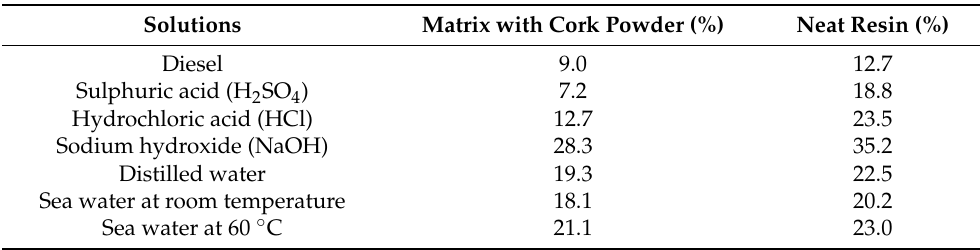
Table 8. Difference between the restored energy obtained after 30 days of immersion into different harsh solutions compared to that obtained with non-immersed